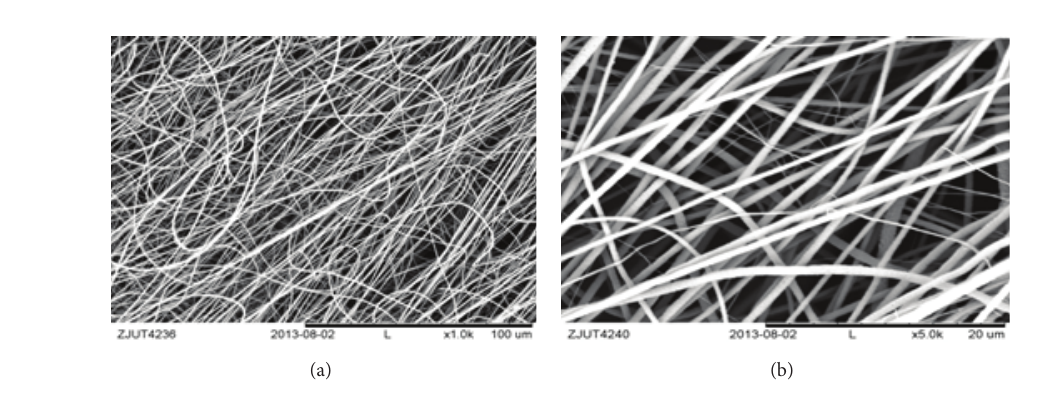
Figure 3: SEM images of masks after 15min electrospinning. (a) × 1000 and (b) × 5000.